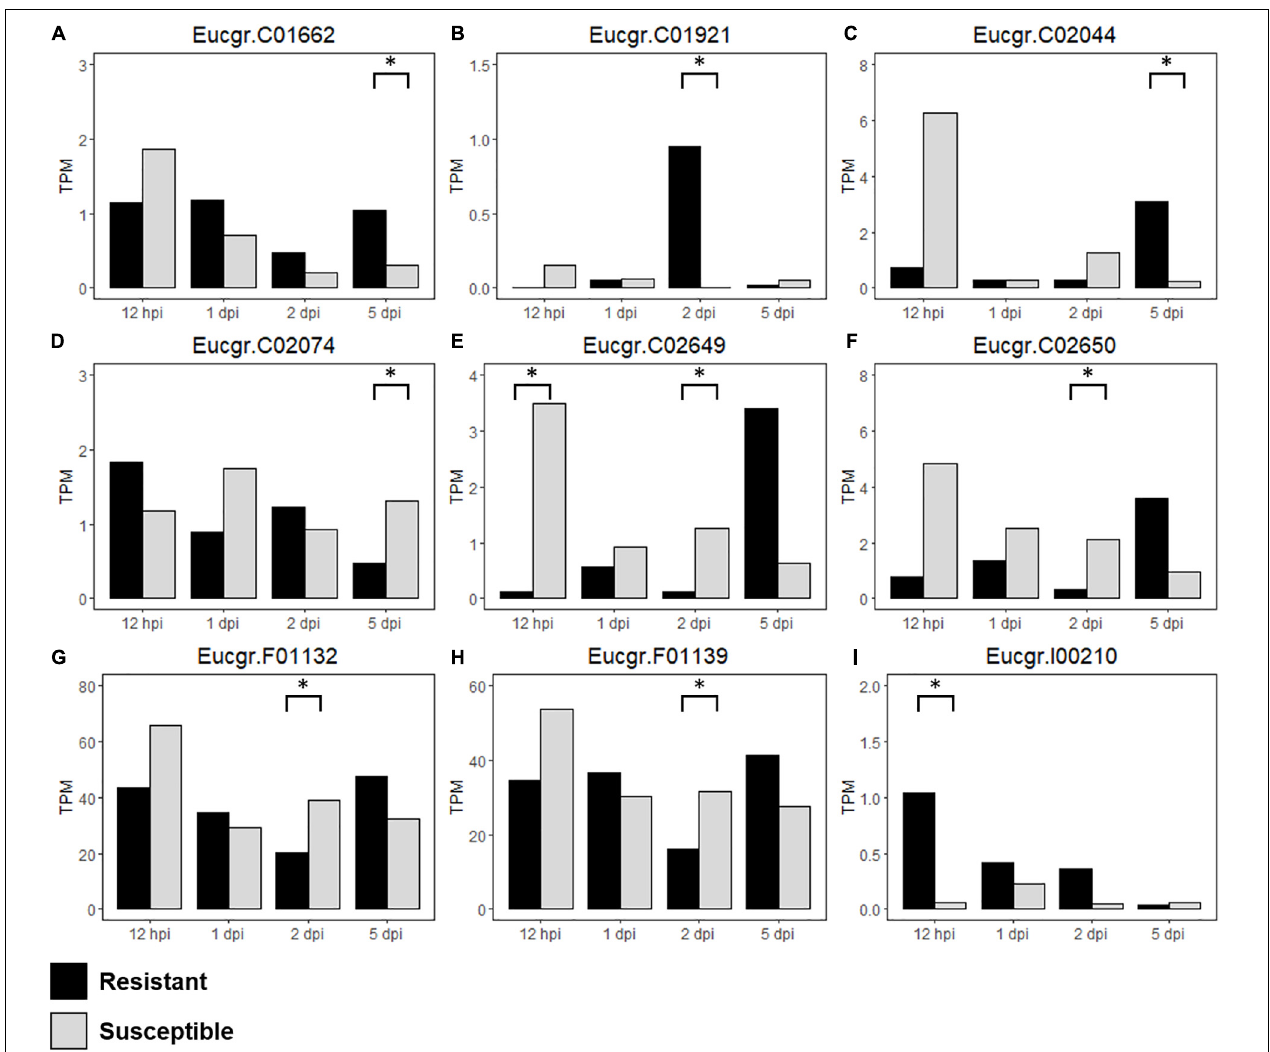
FIGURE 7 | Differentially expressed (DE) R-genes (A–I) underlying the Austropuccinia psidii resistance loci in the susceptible, control compared to resistant, control seedlings over the time series, representing TPM values of DE R-genes in all biological replicates in the controls of the R- and S-interactions i.e., constitutive expression of the R-genes are being compared, where black represents resistant and light gray represents susceptible seedlings and asterisks represent significant